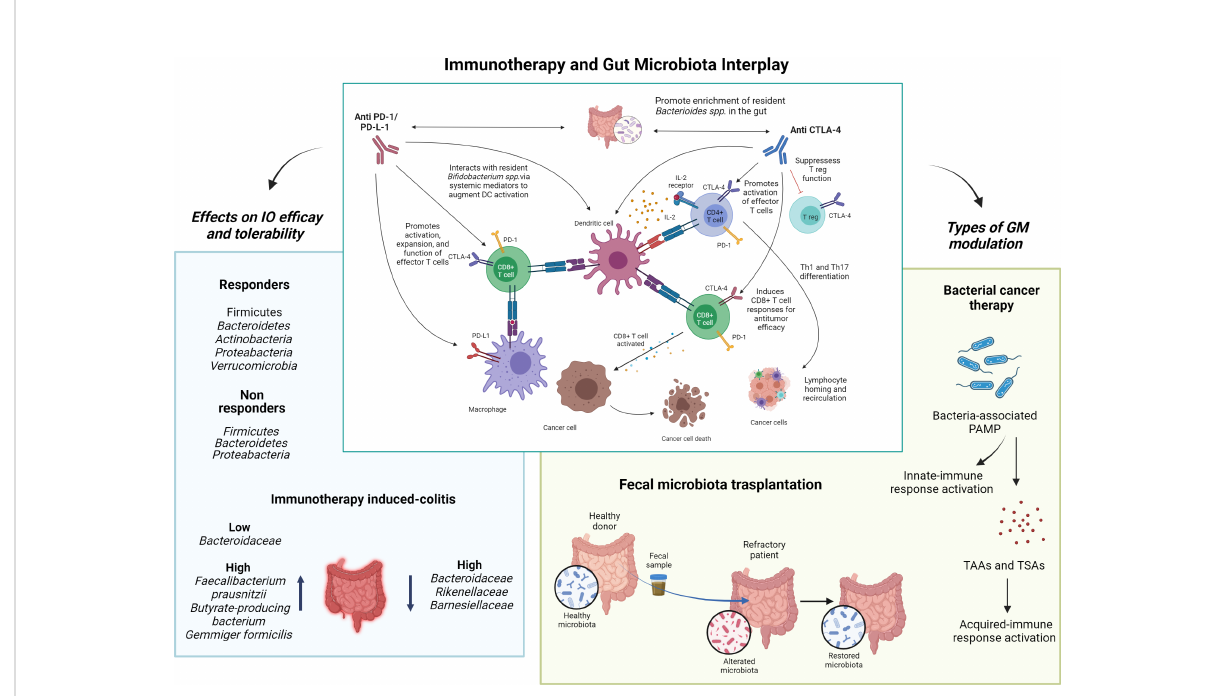
FIGURE 1 Immunotherapy and gut microbiota interplay. The interaction between gut microbiota and immune checkpoint inhibitors, and the expected consequences on the immune system, is represented in the center. Left, the impact of different microbial species on the ef fi cacy of immune checkpoint inhibitors and immune-related toxicity is shown. Right, the two main gut microbiota modulation strategies discussed in this Research Topic are shown as possible tools for improving the ef fi cacy and toxicity of immunotherapy. I-O, immuno-oncology; GM, gut microbiota; PD-(L)1, programmed death cell-(ligand)1; CTLA-4, cytotoxic T-lymphocytes associated protein-4; PAMP, molecular patterns associated with pathogens; TAAs, tumor-associated antigens; TASs, tumor-speci fi c antigens. Image created using